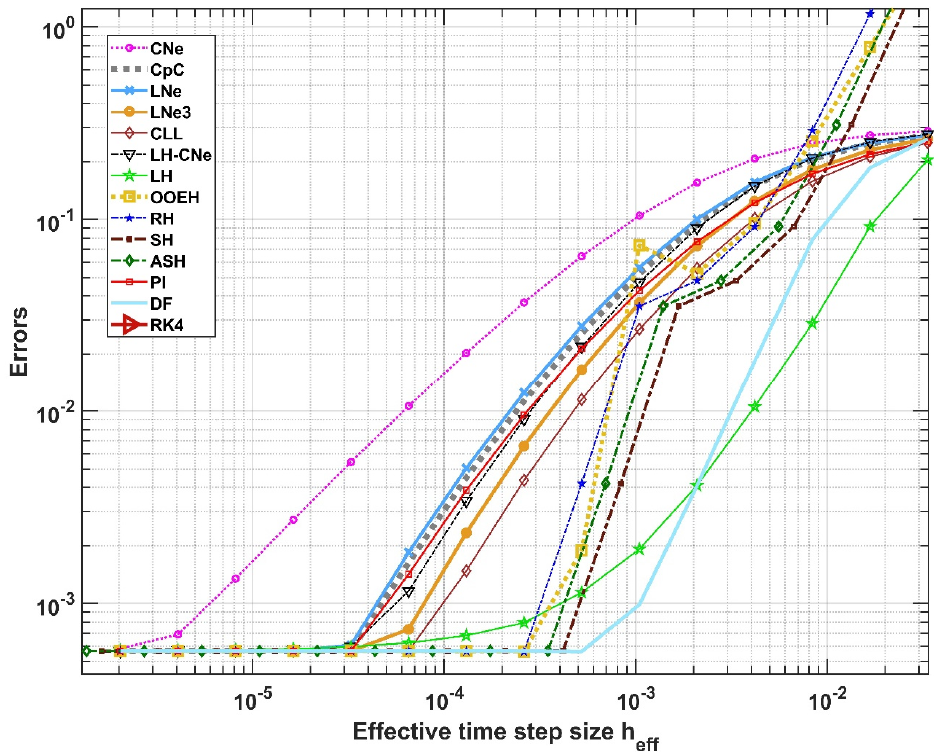
Figure 14. The L ∞ errors as a function of the time step size h for a decreasing mesh (Experiment 5). RK4 is not present in the figure because it is unstable for the examined time step sizes, as it is stable only below h ≈ 3.2 · 10 − 8 Table 4. Errors and numerical order of different algorithms for Experiment 5.